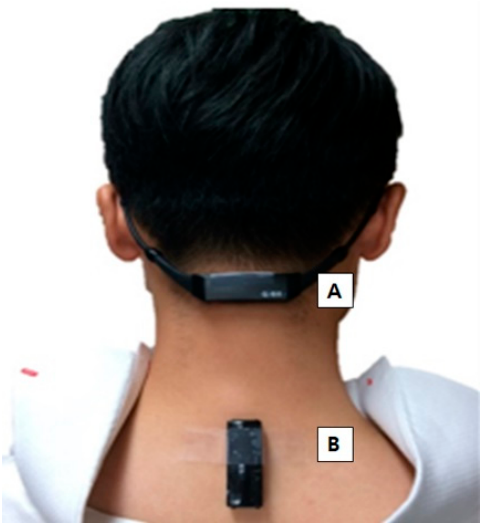
process area, just below the prominence of